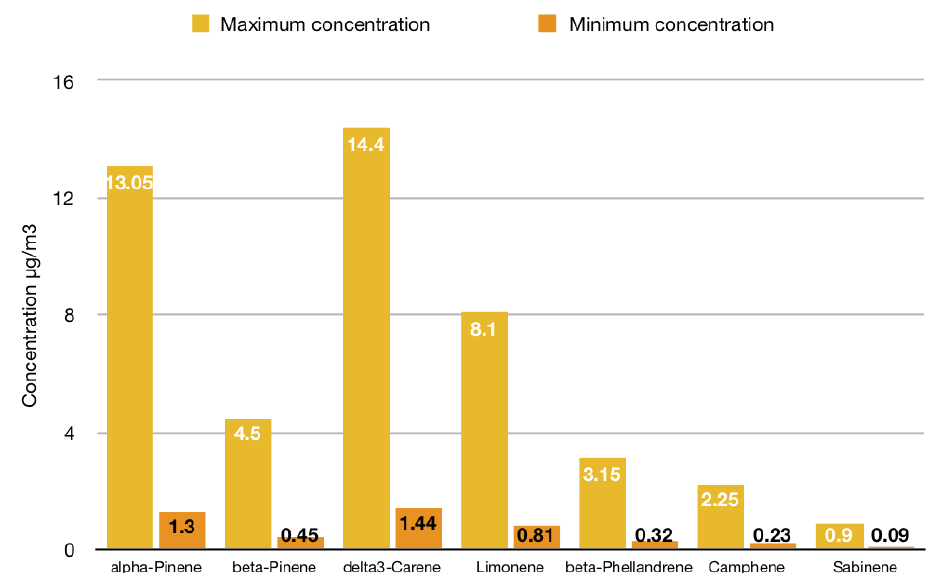
Figure 4. Atmospheric concentrations of seven monoterpenes under the canopy of a Scots pine forest [44].